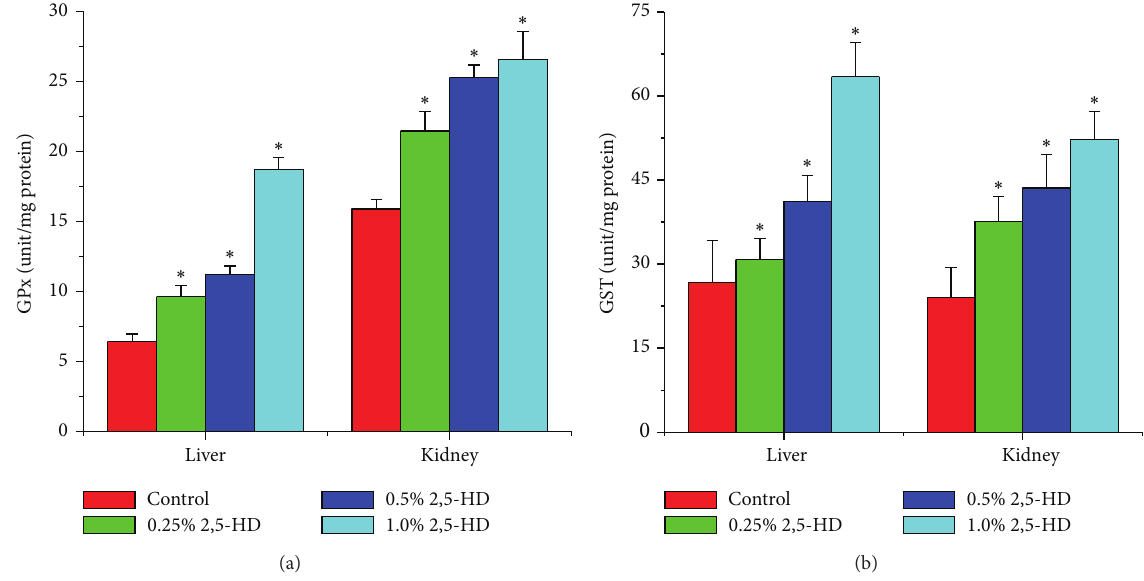
Figure 2: Comparison of hepatic and renal GPx and GST activities among the control and treated rats ( 𝑁 = 8 ). Values represent mean ± SD of enzyme activity (unit/mg protein of tissue). Asterisk indicates statistical difference from control ( 𝑃 < 0.05